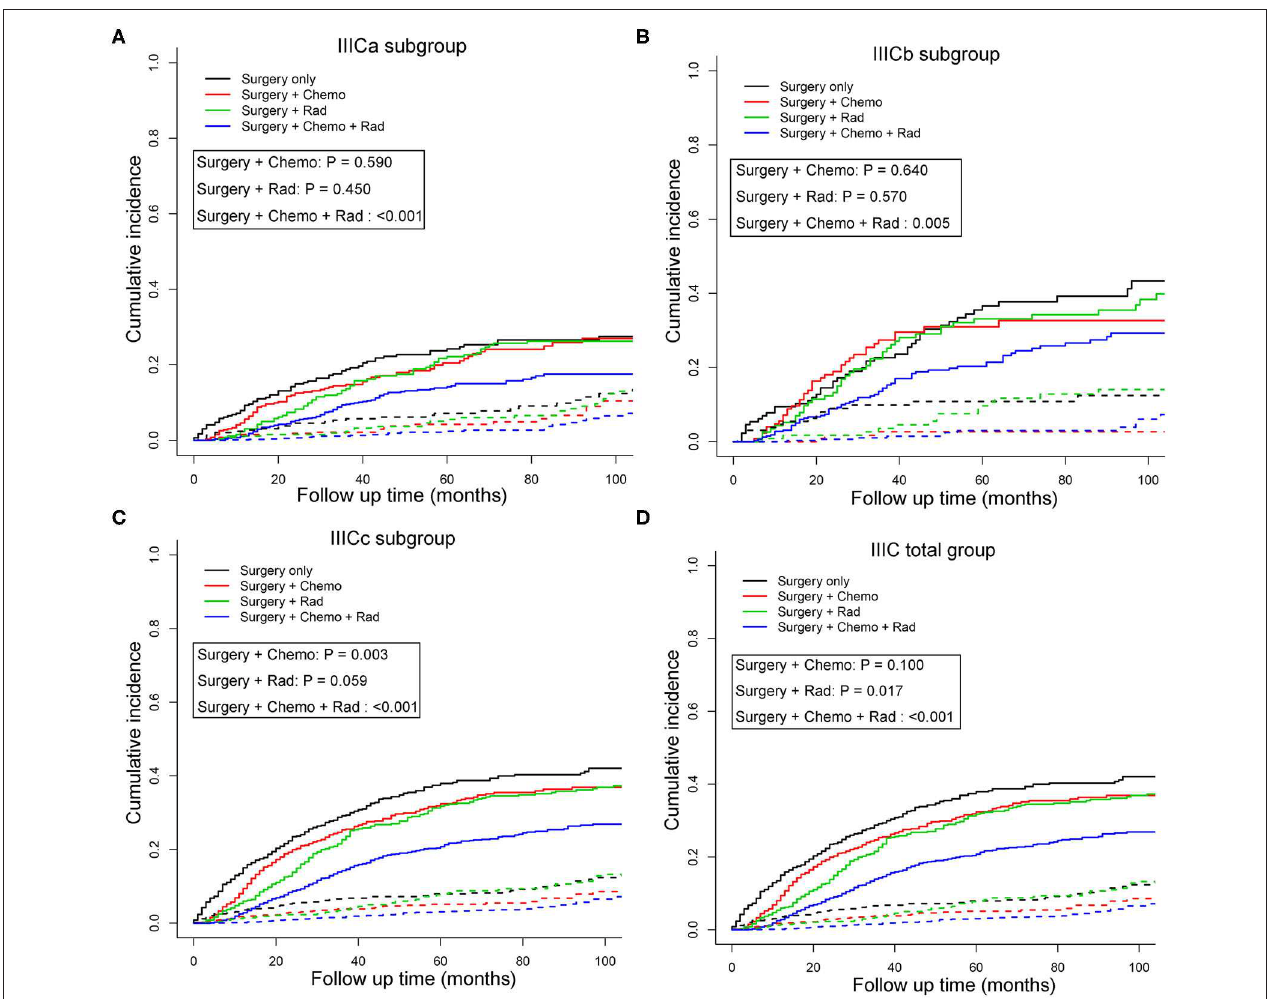
FIGURE 2 | Cumulative incidence curves of cancer-specific mortality stratified by treatment modalities in patients with IIICa (A) , IIICb (B) , IIICc (C) , and IIIC (D) in the total set. Patients receiving surgery only were set as the reference and the P -values for Gray’s test were presented. The solid and dashed lines in A – C denote cancer-specific death (CSD) and non-cancer specific death (non-CSD). IIICa consists of patients with T1N1 or T1N2; IIICb consists of patients with T2N1 or T2N2; IIICc consists of patients with T3N1 or